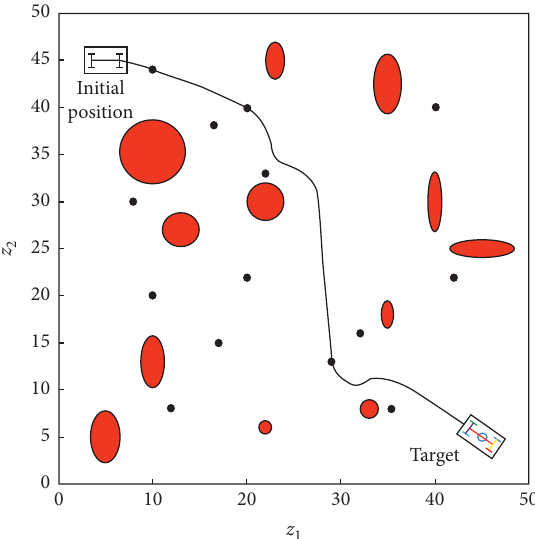
Figure 11: Landmark navigation of a car-like robot in an obstacle- ridden workspace with initial position at ( 5 , 45 ) and target at ( 45 , 5 )